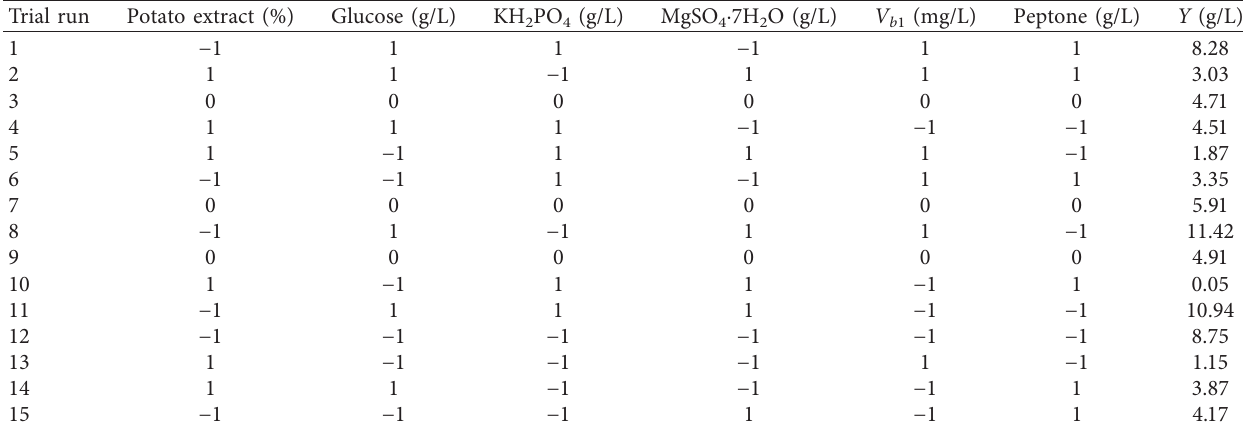
Table 4: Experimental design and results of the Plackett–Burman experiment.